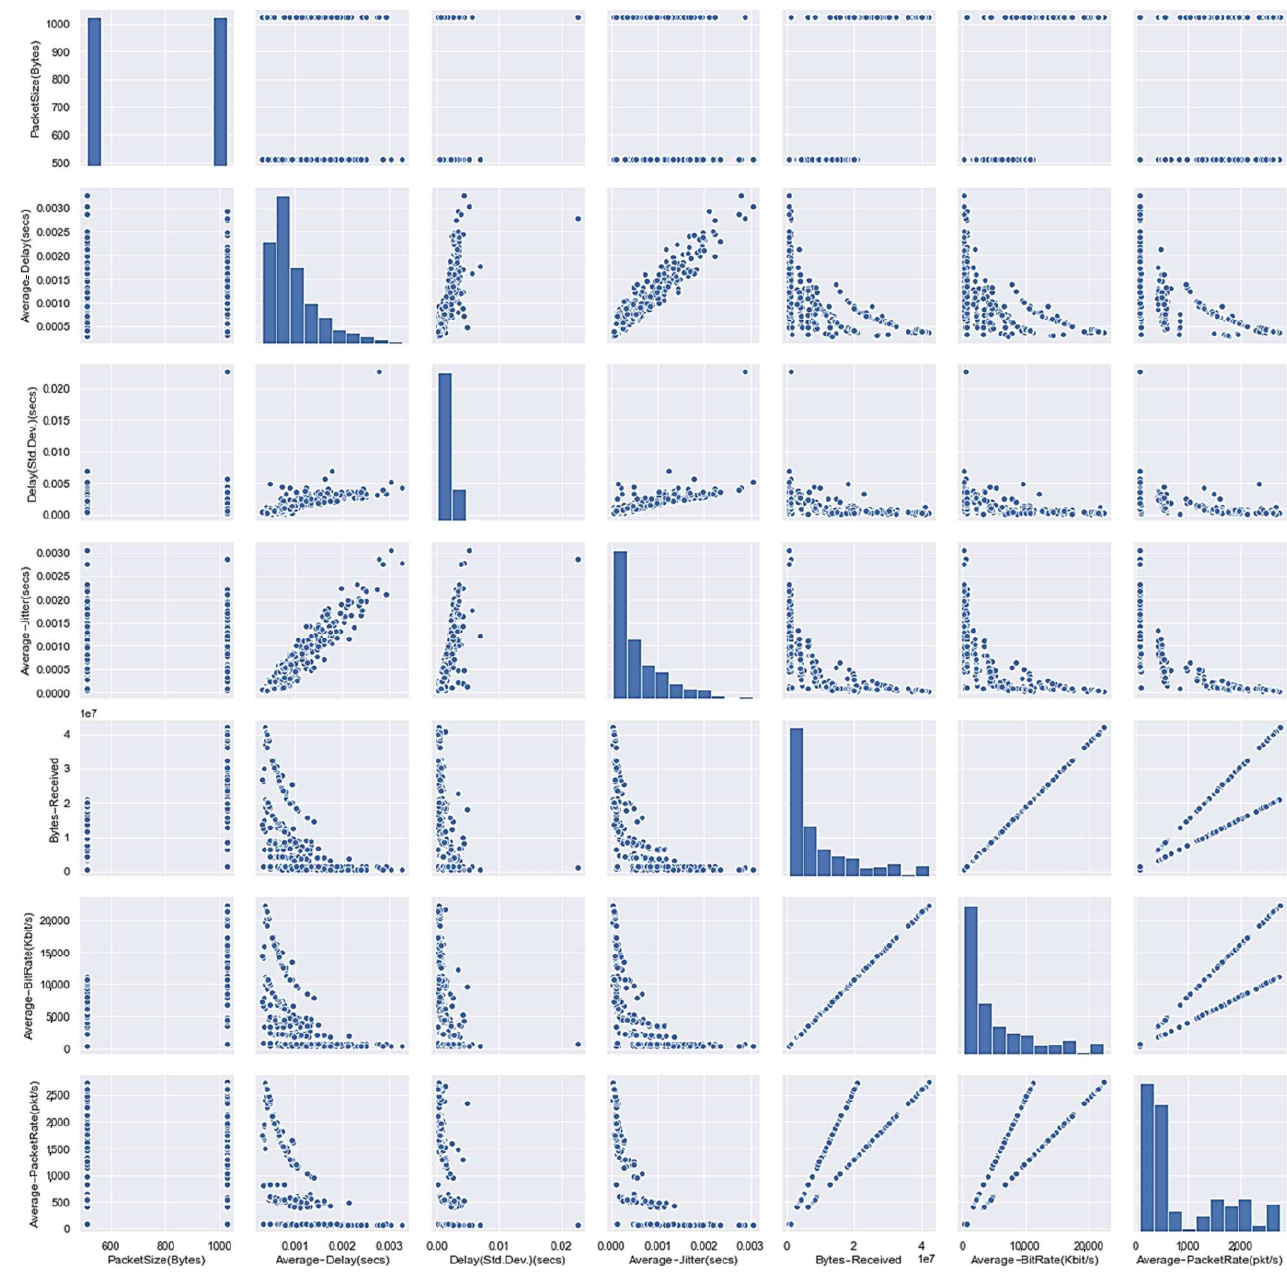
Figure 7. Pair-plot of